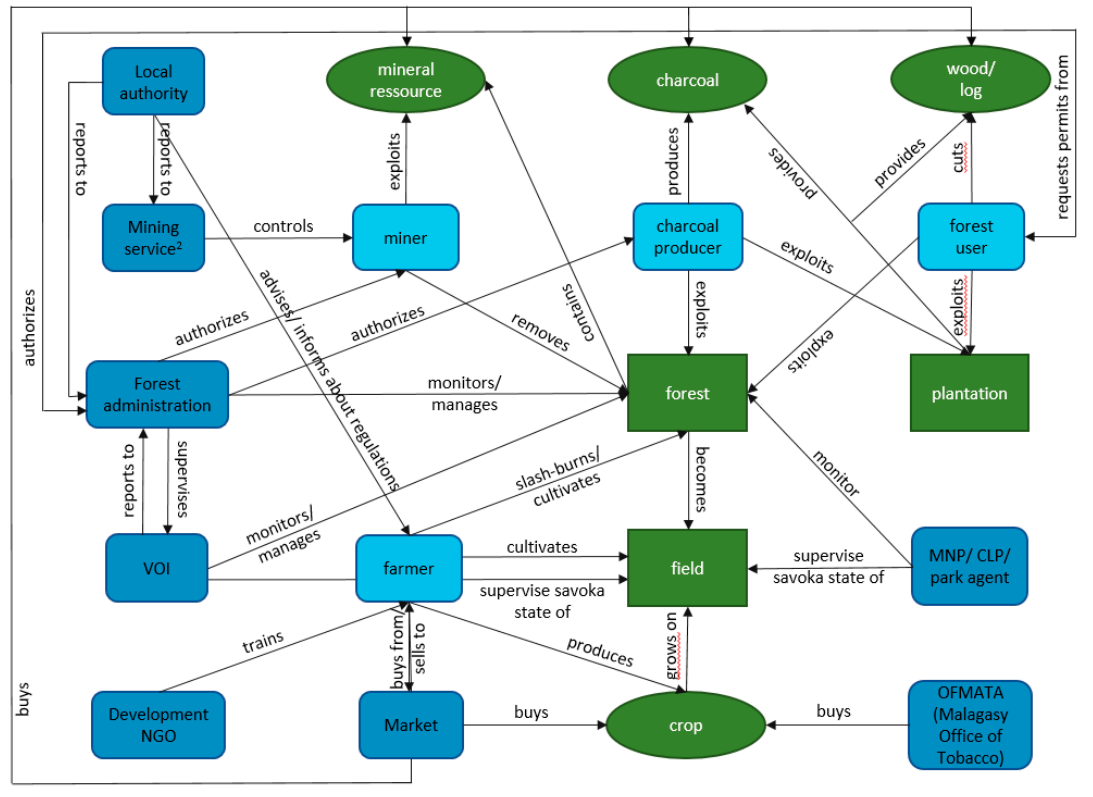
Figure 2. Conceptual model of the Zahamena socio-ecological system showing the interactions of actors and resources. Actors represent either individuals (light blue) or institutions (dark blue); resources are either primary (square boxes) or commodities (ellipsoids). The verbs on the arrows describe the main interactions between two entities.